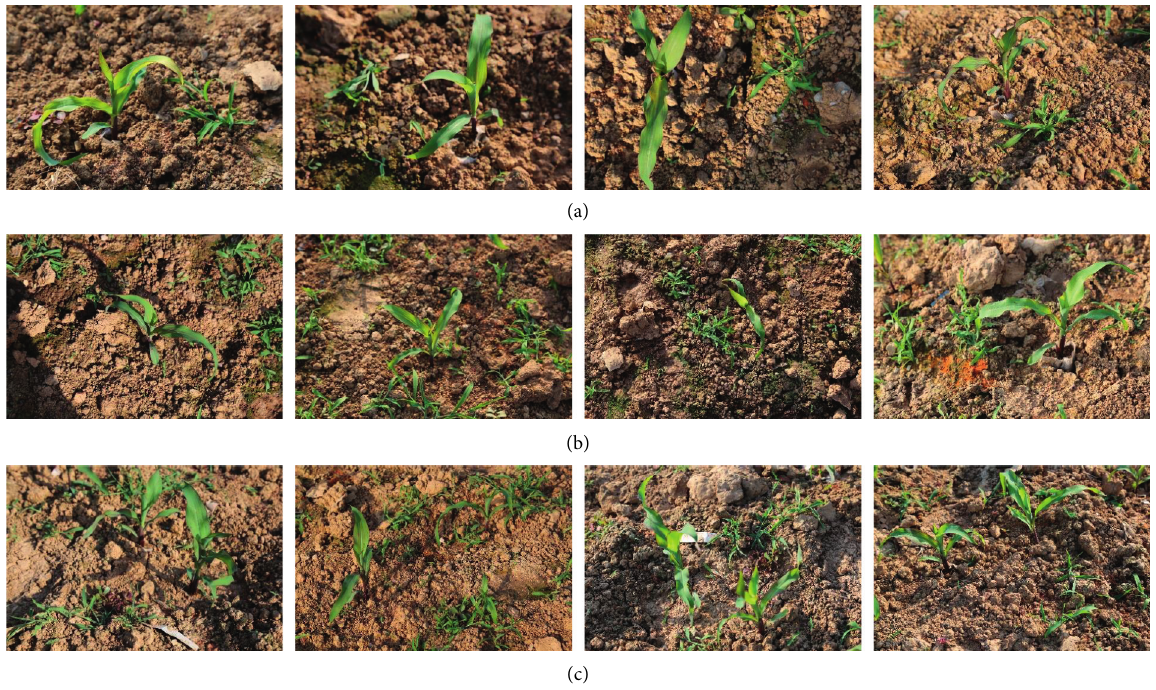
Figure 5: Corn and weed images under natural conditions were collected in the agricultural experimental field. (a) Single plant of corn and single weed images. (b) Single plant of corn and multiple weeds images. (c) Multiple corn and multiple weeds images.